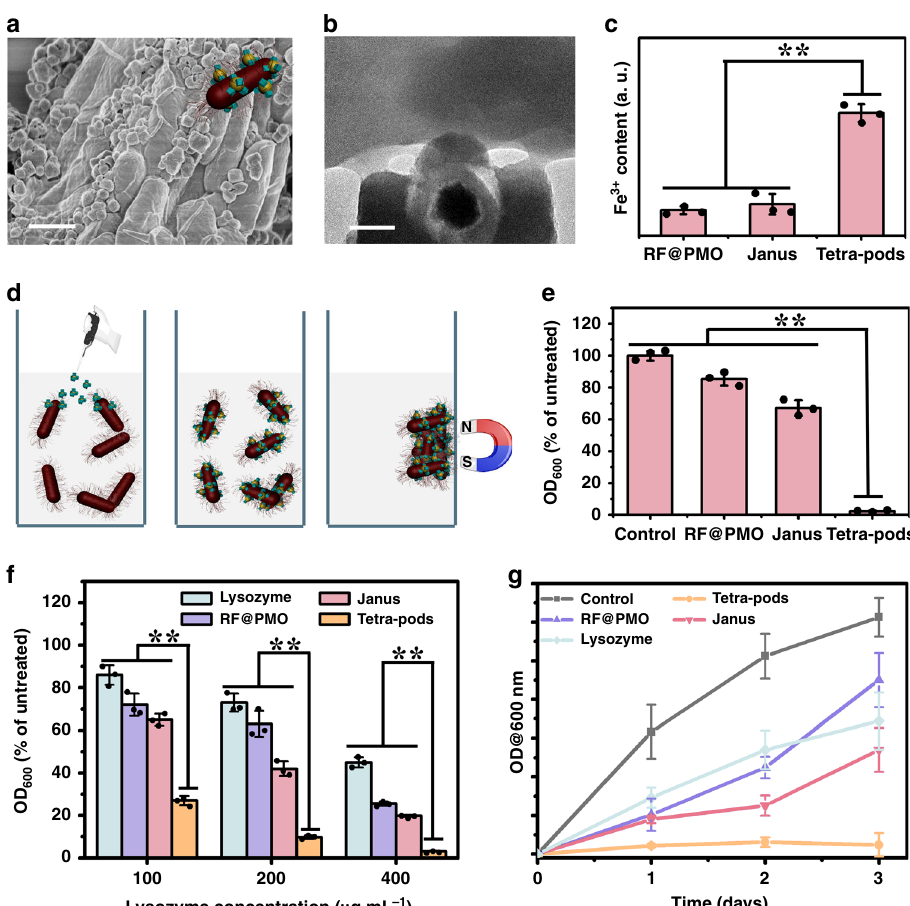
Fig. 5 Surface topologies enhanced bacterial adhesion and inhibition. a SEM, b TEM images and (inset of a) 3D structural model of the tetra-pods Fe 3 O 4 @SiO 2 @RF&PMOs nanoparticles adhered on E. coli surfaces. Scale bars represent 1 μ m for a, 100 nm for b . c Quantitative analyses of the nanoparticles adhered on bacteria from ICP based on Fe 3 + concentration: the tetra-pods Fe 3 O 4 @SiO 2 @RF&PMOs (Tetra-pods), Janus Fe 3 O 4 @SiO 2 @RF&PMO (Janus) and core@shell Fe 3 O 4 @SiO 2 @RF&PMO (RF@PMO) nanocomposites. d Schematic illustration of the adhesion and magnetic induced separation of E. coli with the multipods nanocomposites. e Quantitative analysis of E. coli in the PBS solution after the magnetic induced separation process. Optical density (OD) value is positive correlated with the amount of bacteria in the solution. f E. coli inhibition ef fi ciency of different nanoparticles loaded with the same amount of lysozyme within 24 h. g The time-dependent E. coli inhibition evaluation of different nanocomposites loaded with the same amount of lysozyme (400 μ g mL − 1 ). The bars represent mean ± s.d. derived from n = 3 groups of bacteria suspension. Source data underlying c , e – g are provided as a Source Data fi le. The statistical analysis was performed using one-way analysis of variance (ANOVA), followed by post hoc Tukey ’ s method. ** P <